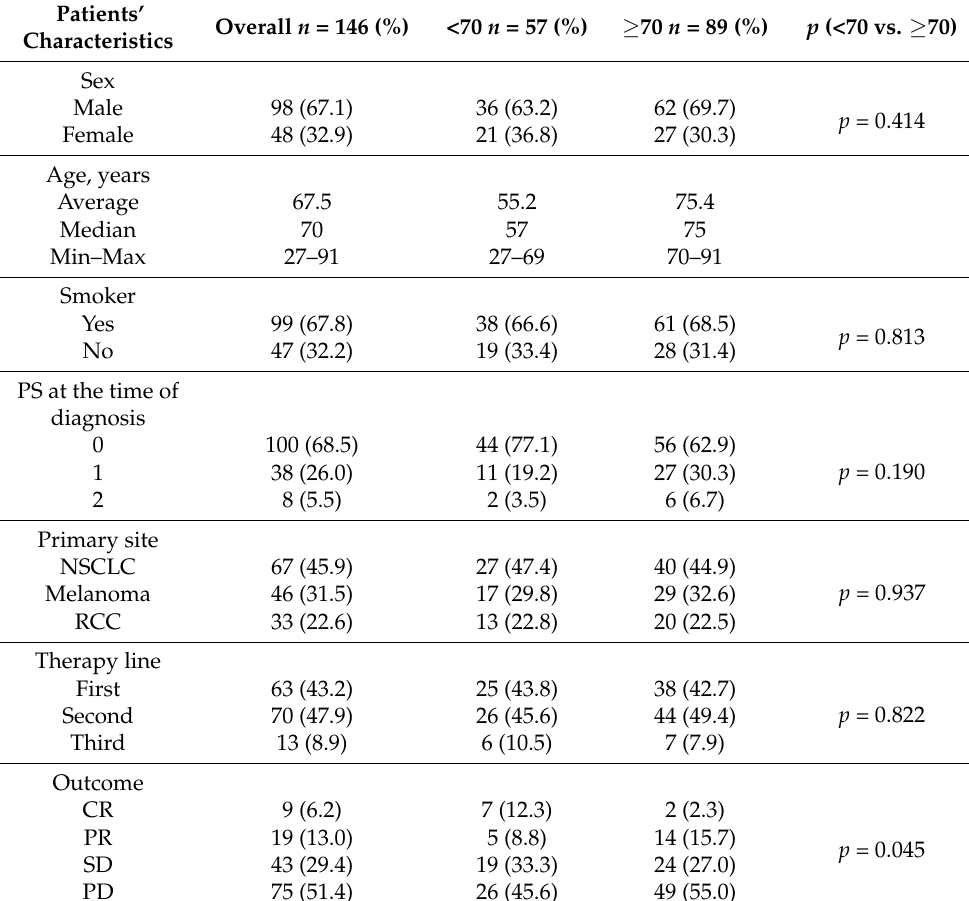
Table 1. Patient characteristics.